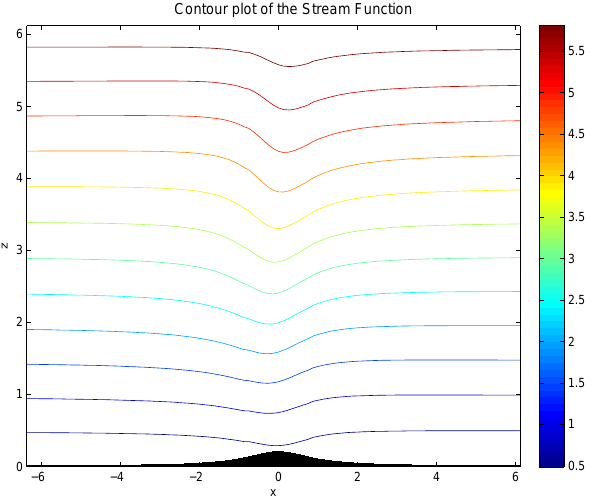
Fig. 1. Solution of Eq. (45) over a “witch of Agnesi” topography with (cid:15) = 0 . 2, δ = 0, N = 1, β = µ = 0.